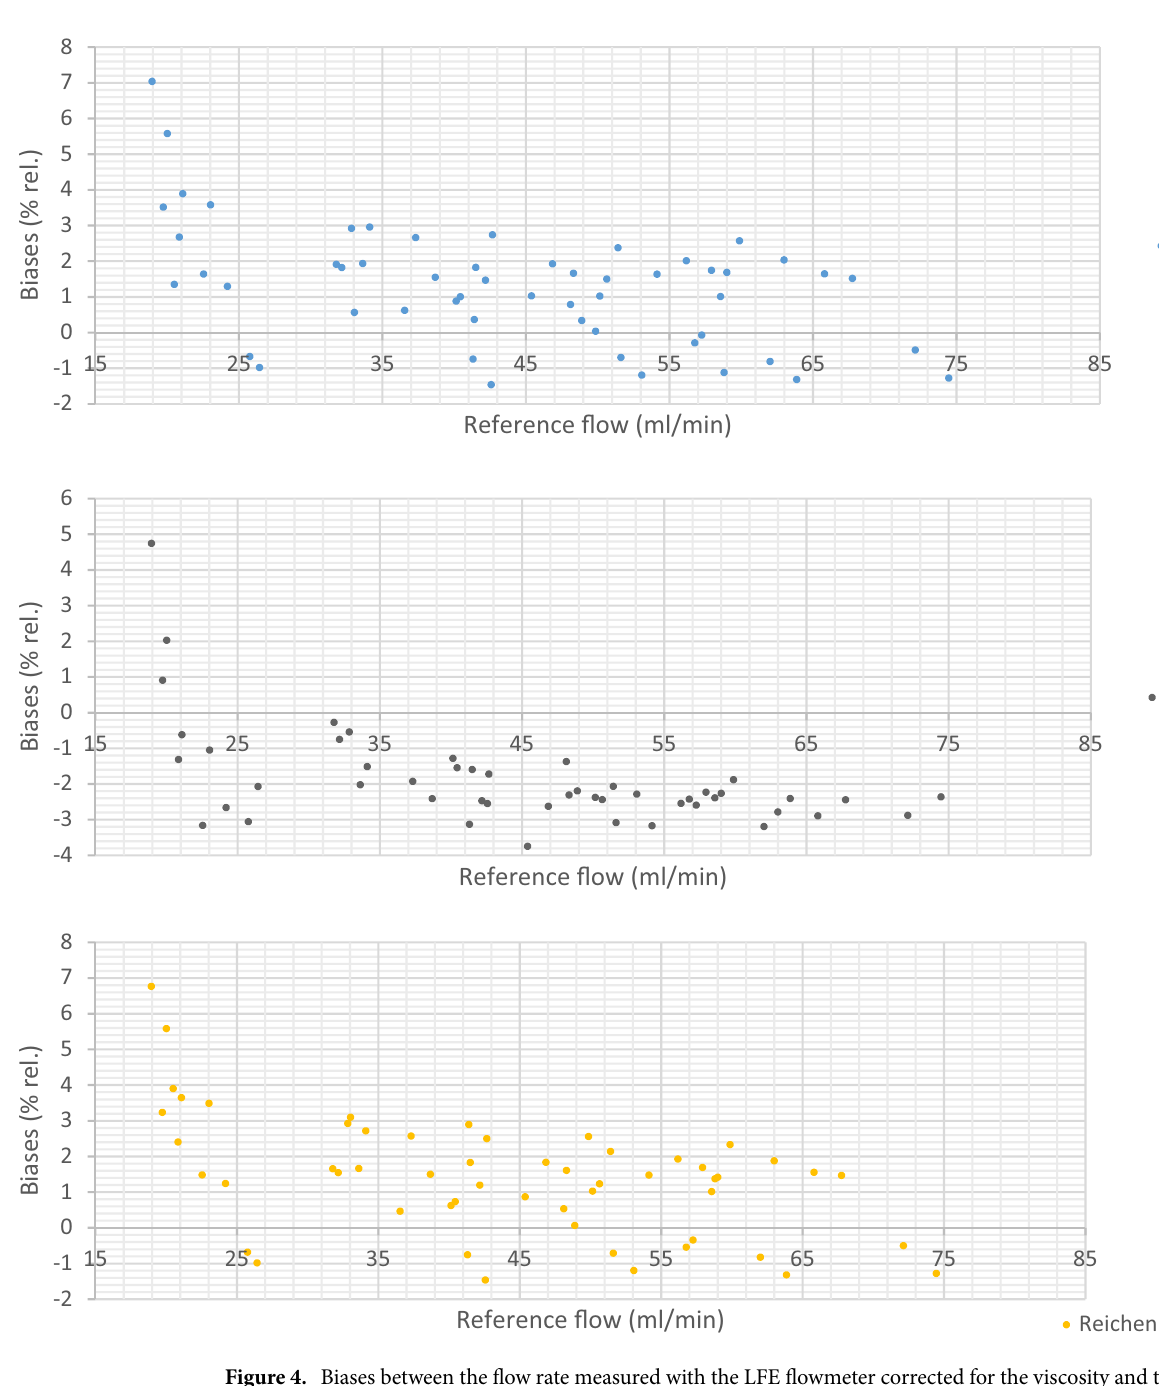
Figure 4. Biases between the flow rate measured with the LFE flowmeter corrected for the viscosity and the reference flow rate for the binary mixtures with the five different models: Carr, Wilke, Reichenberg, Chung and Lucas in this